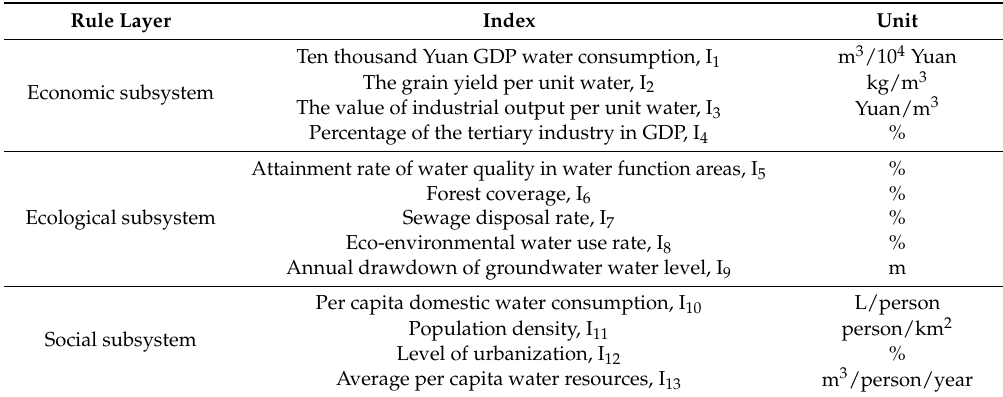
Table 1. Evaluation index system of the sustainable use of water